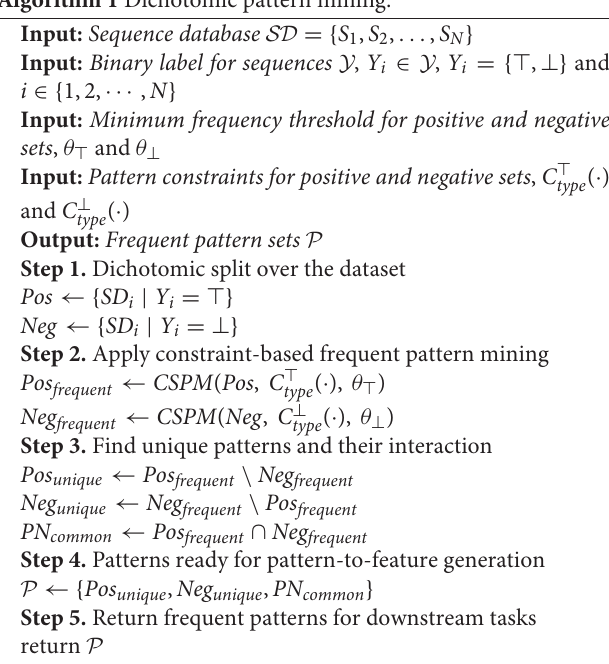
Algorithm 1 Dichotomic pattern